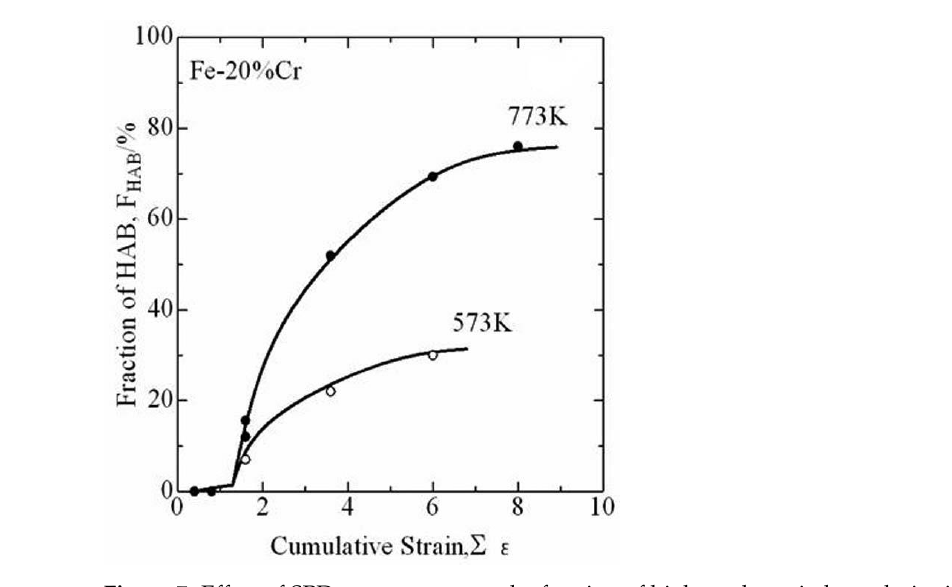
Figure 7. Effect of SPD temperature on the fraction of high-angle grain boundaries in a Fe-20%Cr steel Reproduced from [60], with permission from Springer Nature, 2023.